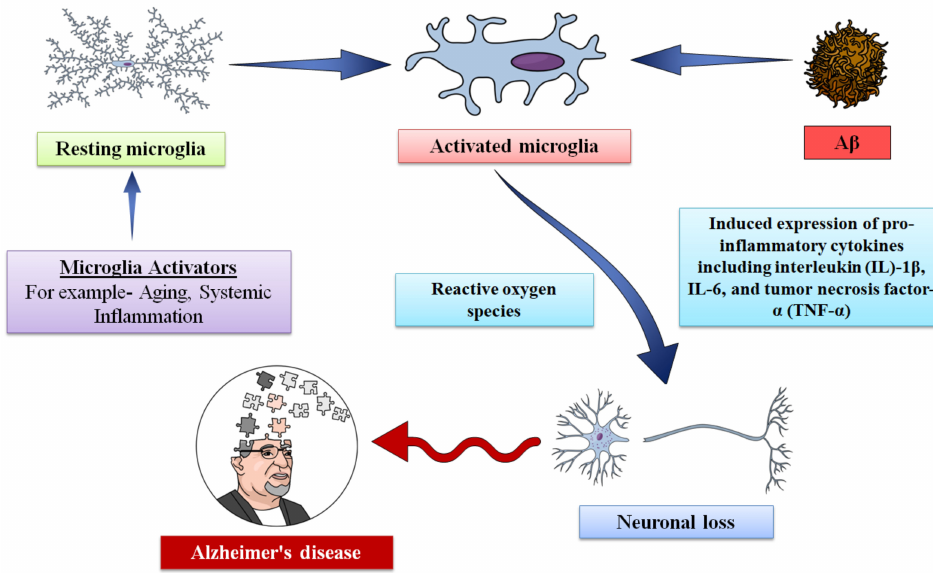
Figure 3. The detrimental roles of microglia in Alzheimer’s